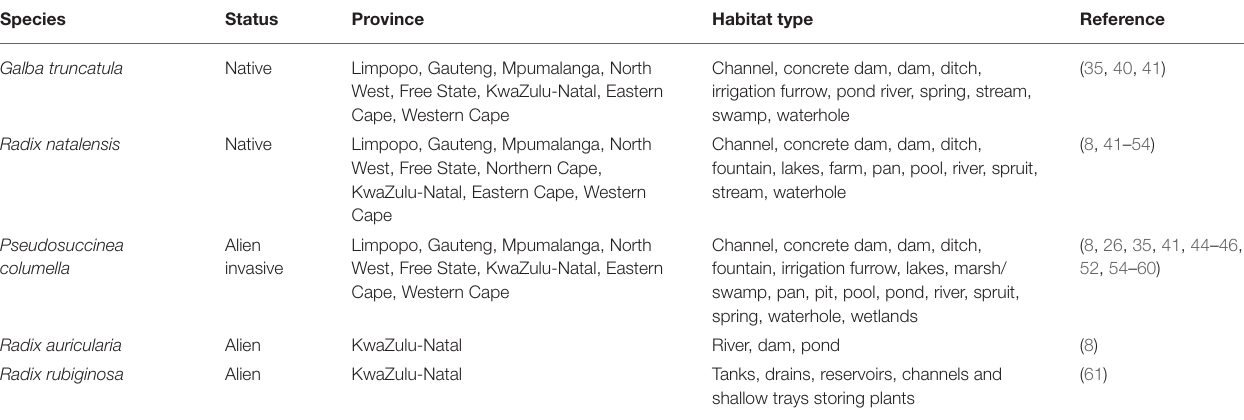
TABLE 2 | Information from reviewed publications on geographical distribution of snail intermediate hosts of Fasciola spp. in South Africa.